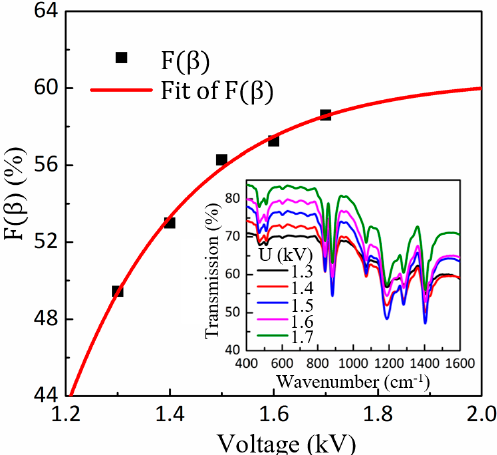
Figure 4. The concentration of β phase F ( β ) versus the applied voltage, the inset graph shows the FTIR transmission spectrum of the PVDF fibers.